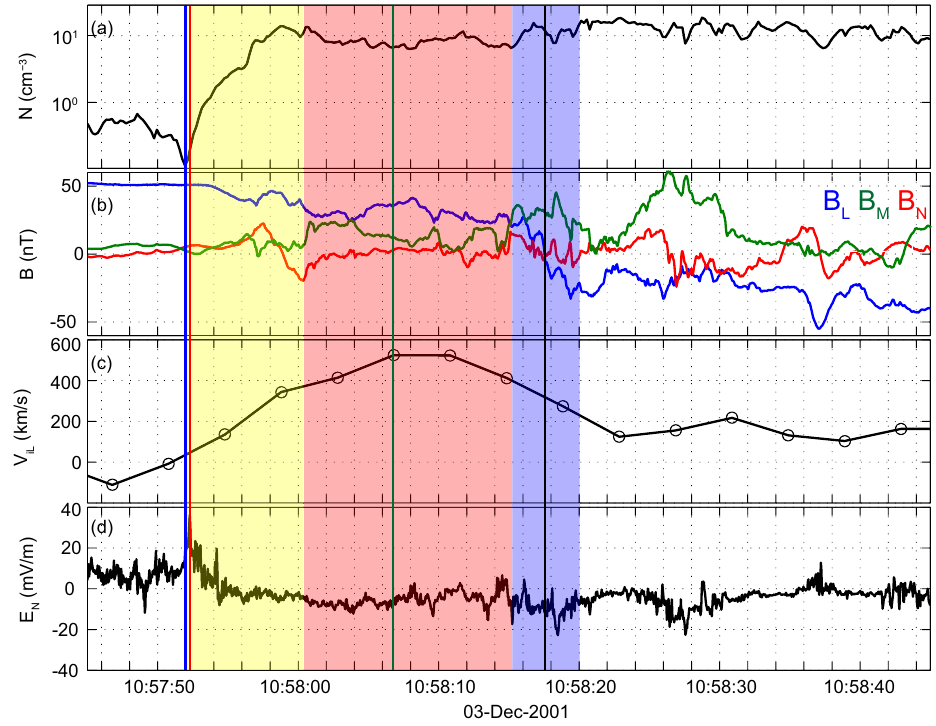
Figure 1 Fig. 1. Magnetopause crossing event observed by CLUSTER spacecraft (Retin`o et al., 2006). (a) The electron number density N e obtained from the spacecraft potential, (b) three components of the magnetic fields, (c) the ion outflow bulk velocity V iL , and (d) the normal compo- nent of the electric field E N . The blue, red, green, and black lines show the locations of the electron density dip, E N peak, V iL peak, and the B L reversal, respectively. A deep electron density dip is seen at the MSP side SR, with a strongly enhanced positive E N peak. Ion outflow jet in the current sheet is biased toward the MSP